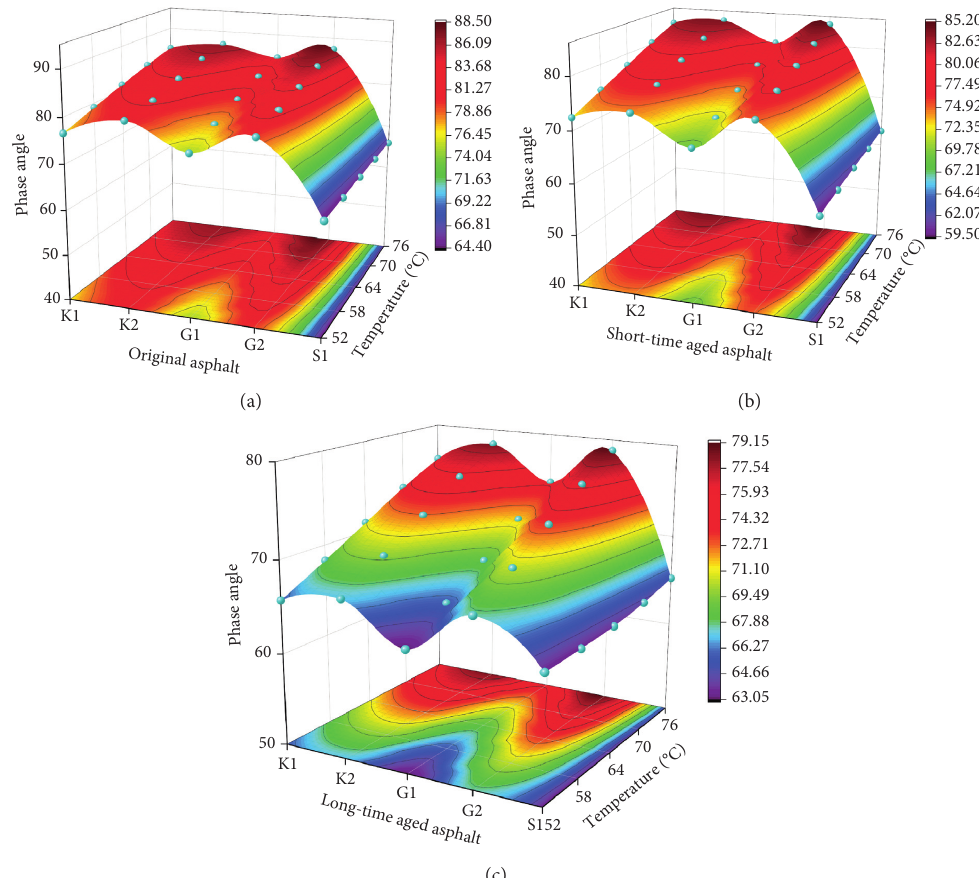
Figure 3: Phase angle at different aging states. (a) Original asphalt. (b) Short-time aged asphalt. (c) Long-time aged